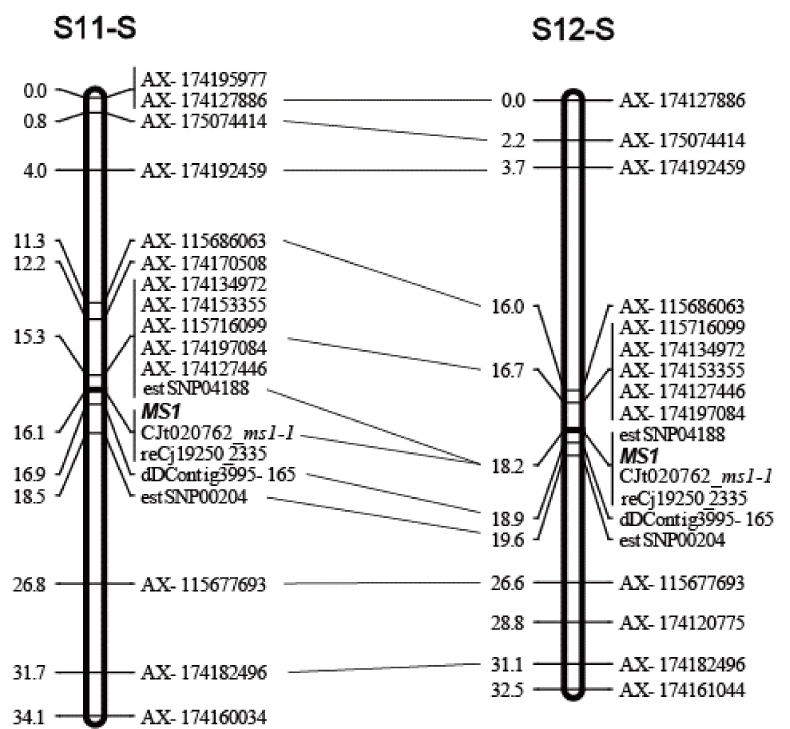
Figure1. Partiallinkagemapsoftheregionencompassing MS1 intheS11-SandS12-S C.japonica